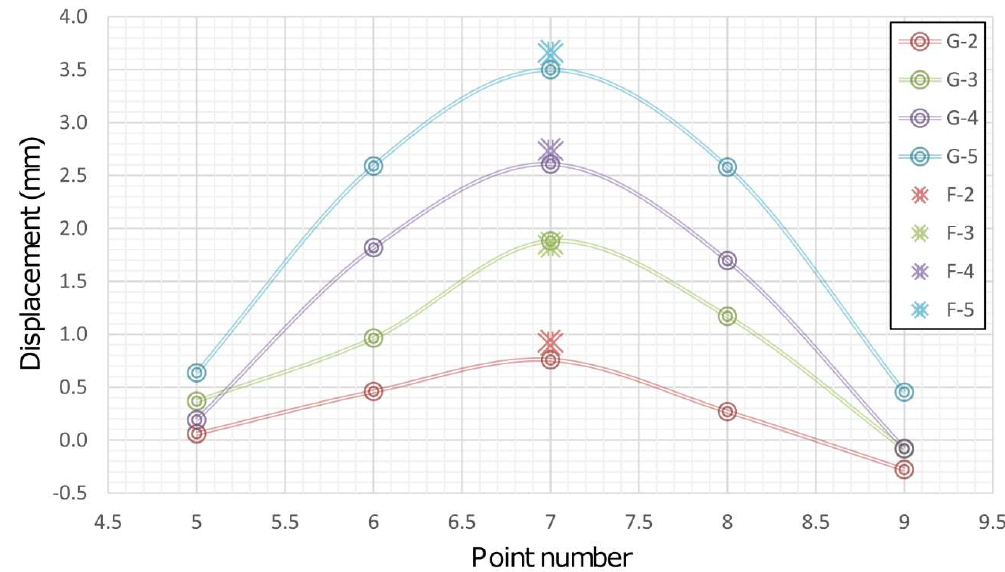
Figure 8. Results of geodetic and 2D deflection sensor measurements without zero series.